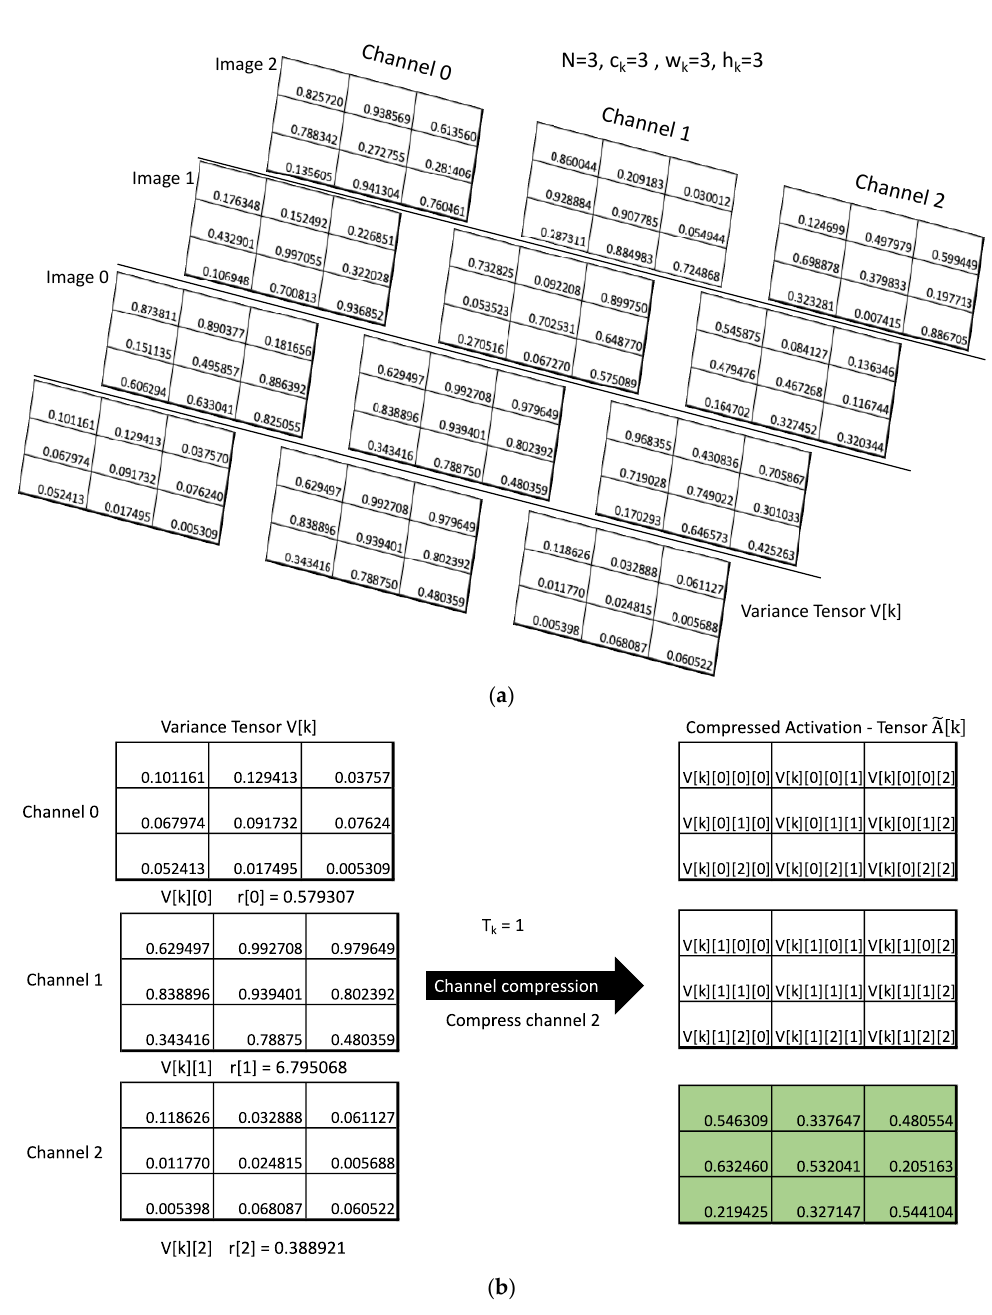
Figure 4. Example of S-VELCRO ( a ) preprocessing and ( b ) compression stages. Algorithm 1: S-VELCRO algorithm for specialized CNNs. During the compression phase, the threshold values of the tuples T that produce the optimal compression saving ratio need to be found. As part of this study, we also introduce a novel automatic hyperparameters tuning process that avoids complex manual tuning. The user provides a target prediction accuracy, and the hyperparameter tuning algorithm searches for the optimal T that meets the target accuracy. Our hyperparameter tuning approach incrementally modifies each element in the tuple T as long as it does not decrease the overall prediction accuracy of the CNN model. This process is repeated for every element in every tuple. After reaching the last element in the tuple, the entire tuning process is repeated, beginning with the first element in the tuple, until the target prediction accuracy has been achieved. If the target prediction accuracy cannot be achieved, the hyperparameter tuning process terminates with the achievable prediction accuracy closest to the